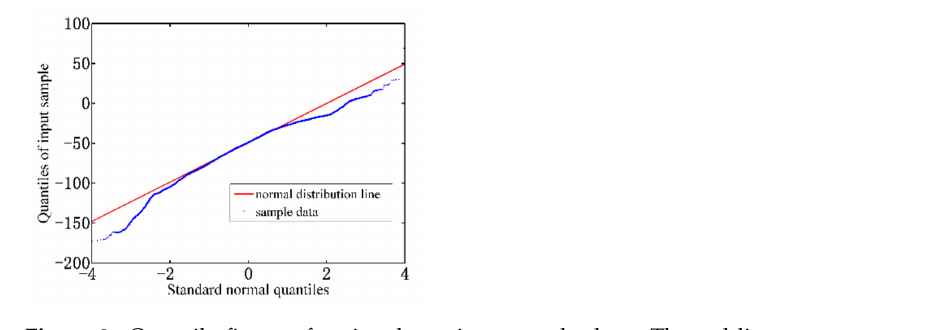
Figure 2. Quantile figure of regional gravity anomaly data. The red line represents a normally distributed line. The blue solid dots represent the regional gravity anomaly data distribution.